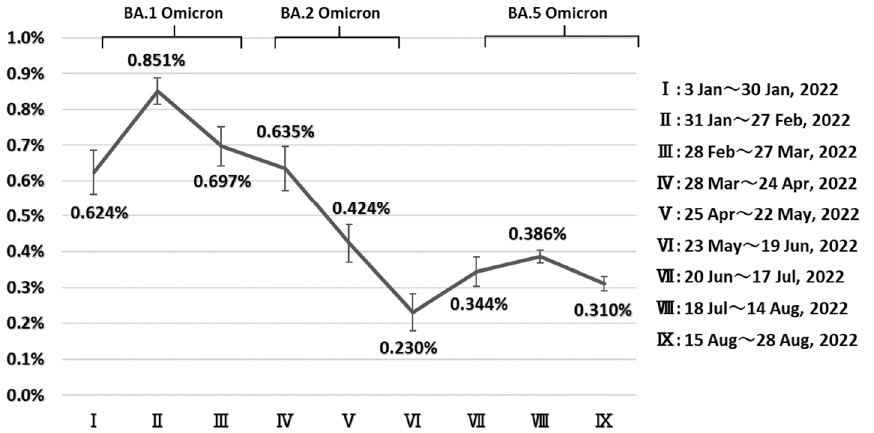
Figure 2. Trends in age‑standardized fatality rate in patients aged 40 years infected with the Omicron variant diagnosed between 3 January and 28 August 2022, in Japan. Age-standardization was performed using the whole Japanese population aged 40 years in 2022. Graph indicates dominant period ( ≧ 85%).